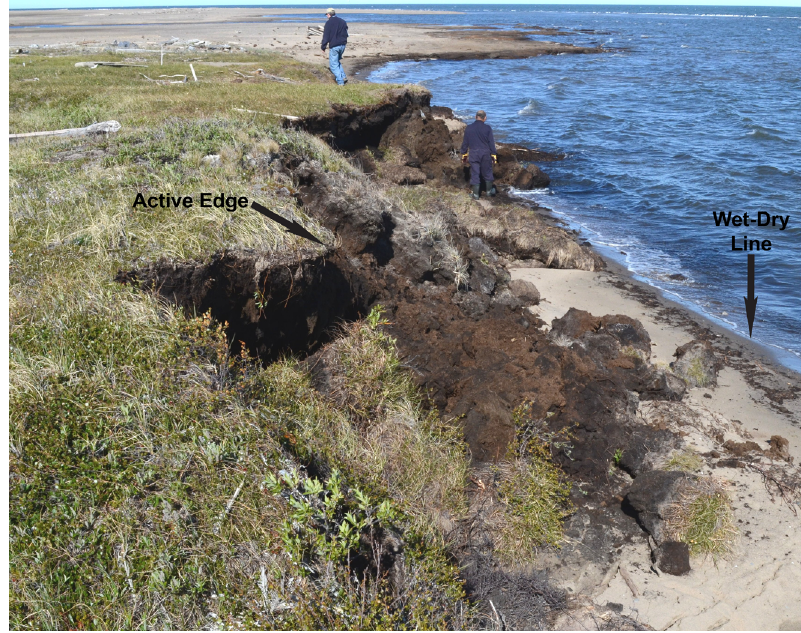
Fig. 6: Eroding shoreline near monitoring stakes at Toker